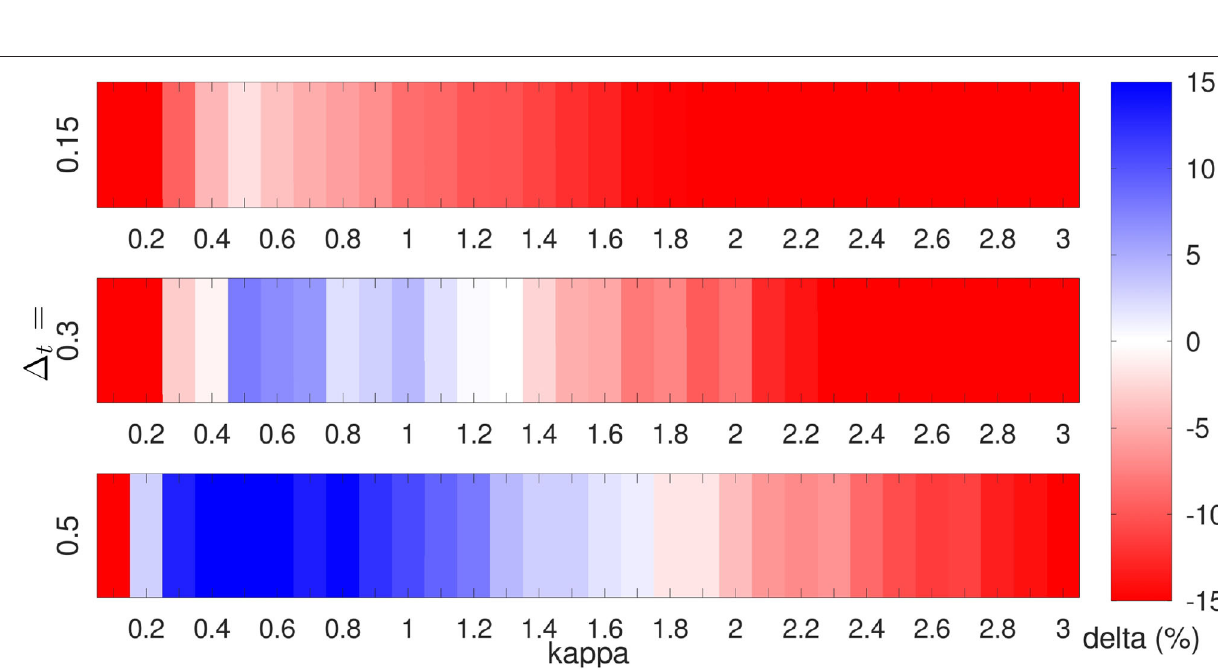
FIGURE 6 | Comparison of background errors of LMCPF and LETKF following Equation (121) for different forecast lengths 1 t values denote a smaller RMSE of truth minus background for the LMCPF method than the LETKF. For each parameter combination, 1,000 data assimilation steps are carried out for the Lorenz 1963 model whereas the last 900 steps are used to compute the statistics. The experiments are repeated 10 times with different seeds and the average error is reported. The true trajectory is generated with σ true noise equals σ obs 0.5. Only the first variable is observed. The ensemble size is set to L =